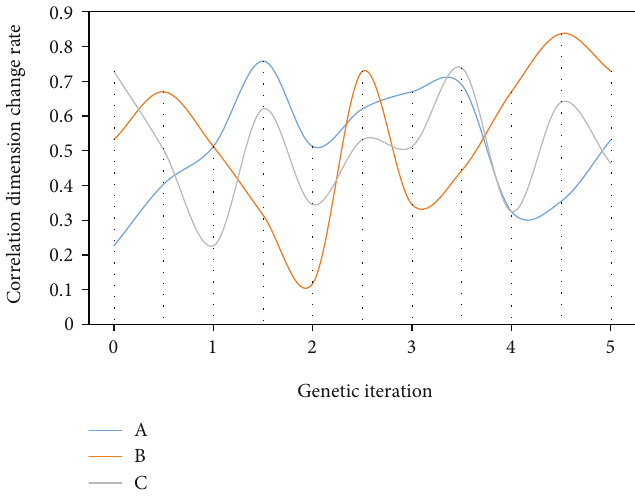
Figure 4: Genetic analysis of association dimension.